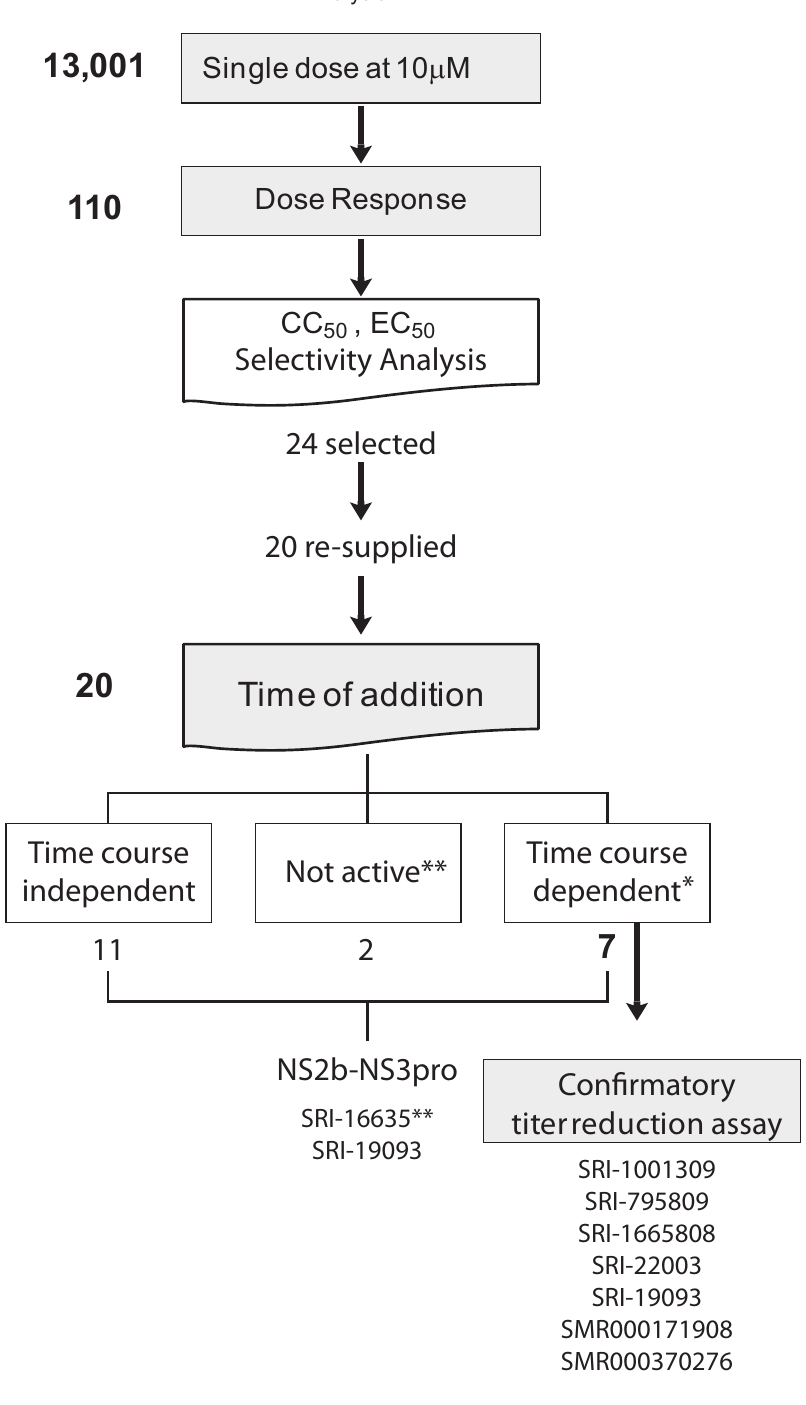
Figure 6. Schematic diagram of discovery for anti-WNV probes from a 13,001 compounds library. The numbers represent the number of compounds tested or